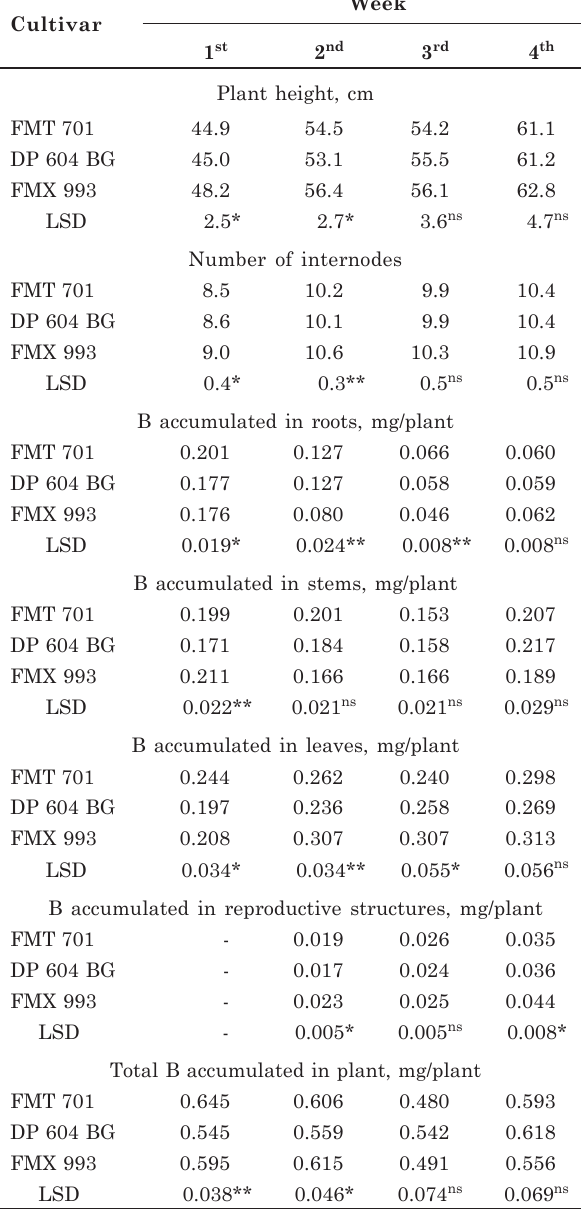
Table 1. Plant height, number of internodes and baron (B) accumulated in cotton roots, stems, leaves, reproductive structures and total B in the plant, obtained in four harvests at weekly intervals starting at the first square (B1), as affected by B rates (0.0, 2.5, 5.0, 10.0 and 20.0 µmol L -1 ) in the nutrient